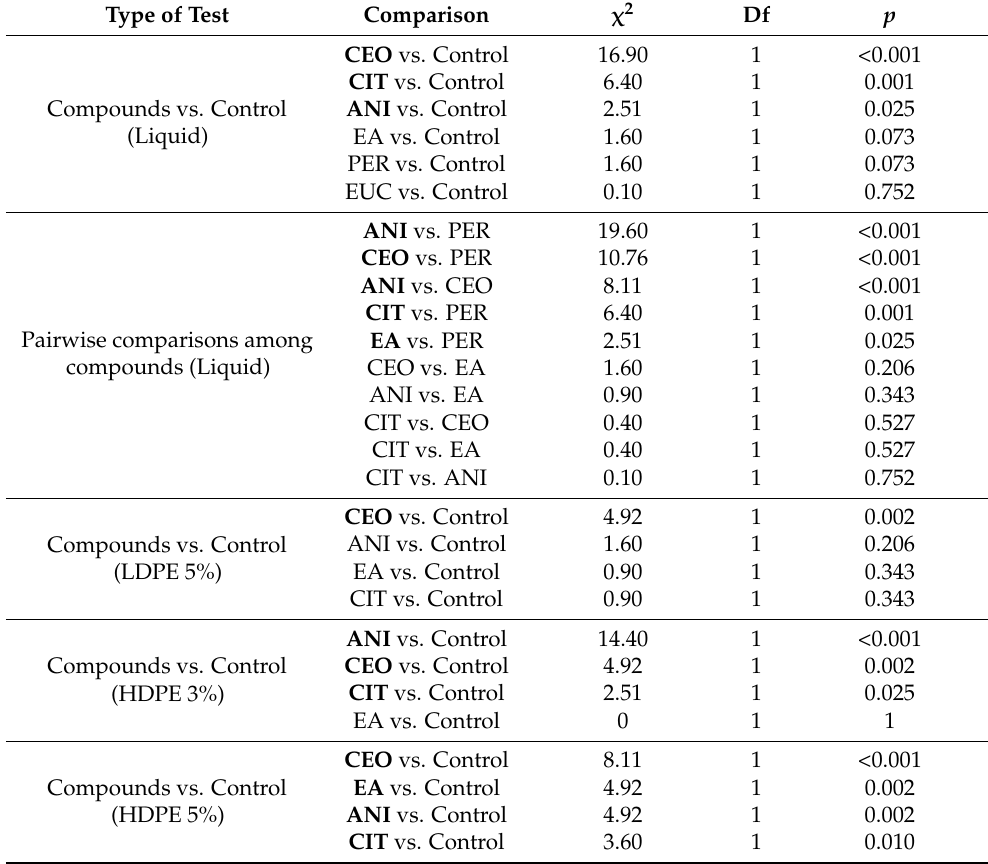
Table 1. Statistics for chi-square goodness-of-fit tests for the effect of the volatiles of different compounds (CEO: cinnamon essential oil; CIT: citronella essential oil; ANI: p-anisaldehyde; EA: ethyl anthranilate; PER: permethrin; EUC: eucalyptol) on the olfactory response of Pheidole pallidula. χ 2 = chi-square values; df = degrees of freedom. Compounds that showed significant repellence are typed in bold in each